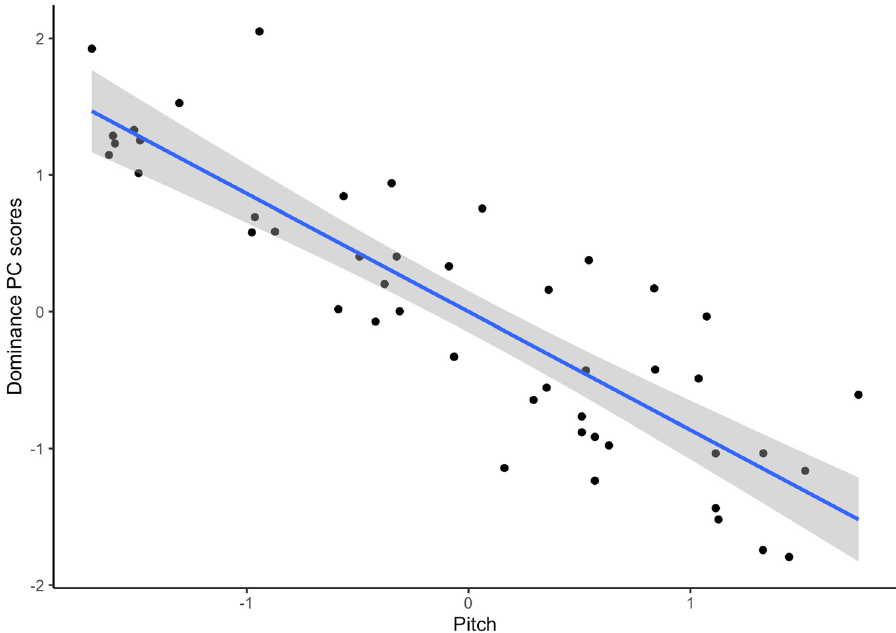
Figure 1. The significant negative relationship between pitch and Dominance PC scores in Study 1. Axes show standardized